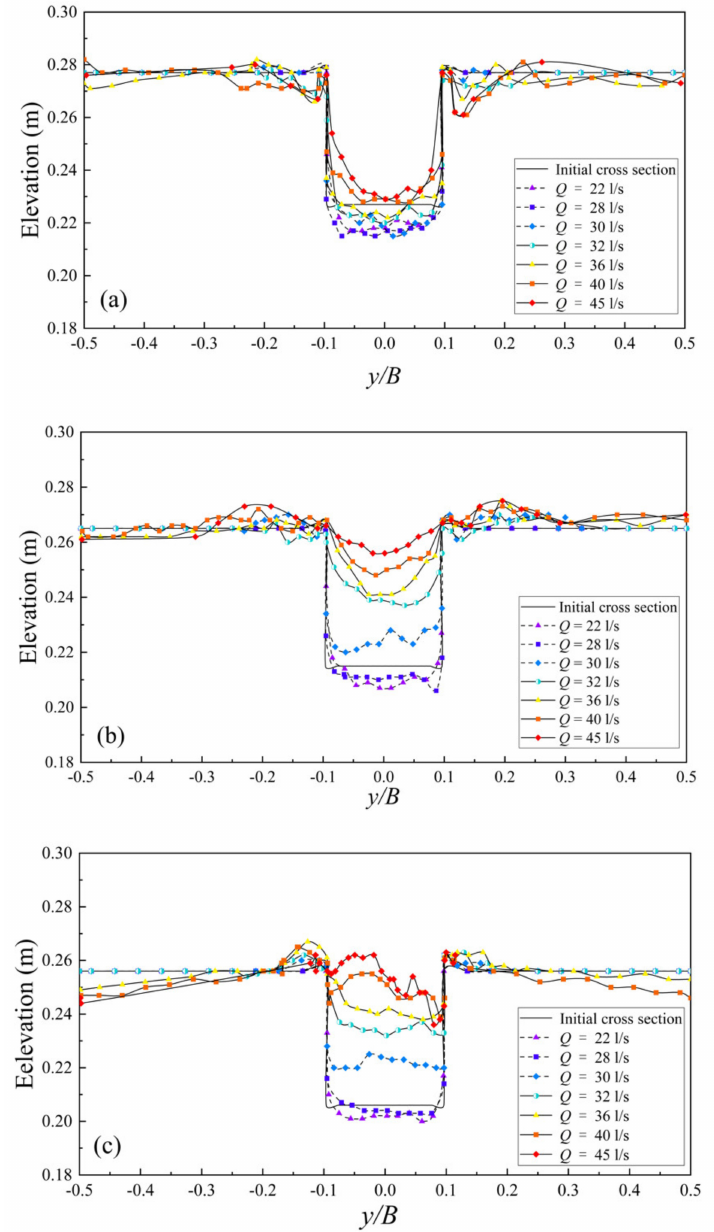
Figure 8. Cross-sectional bed profile at ( a ) x = 2 m, ( b ) x = 5 m, and ( c ) x = 9